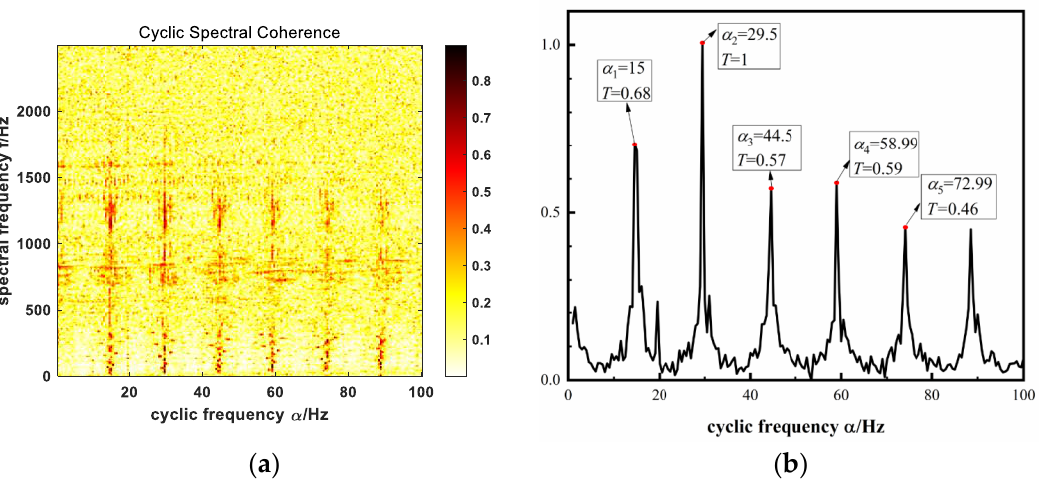
Figure 7. ( a ) The cyclic spectrum coherence function graph of the Robinson R44 helicopter at 1.548 km; ( b ) the cyclic frequency detection results of the Robinson R44 helicopter at 1.548 km.